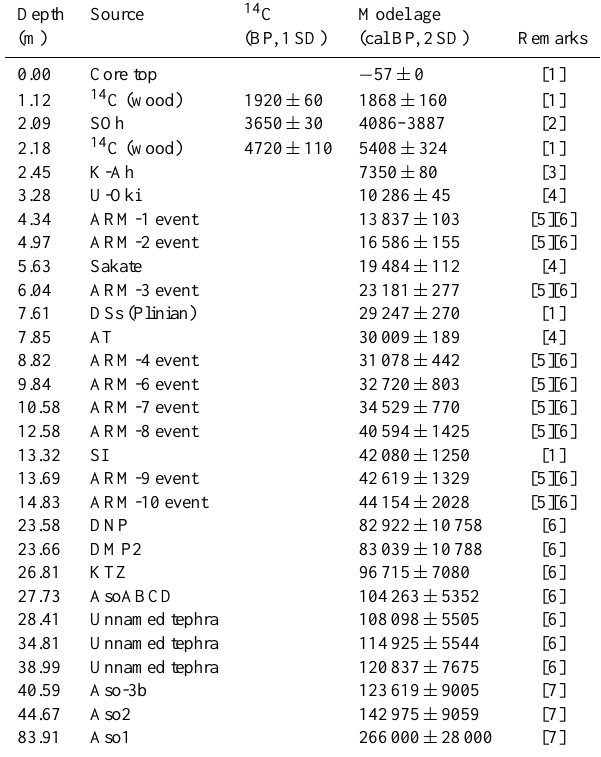
Table 2. Age controls of core BIW08-B.